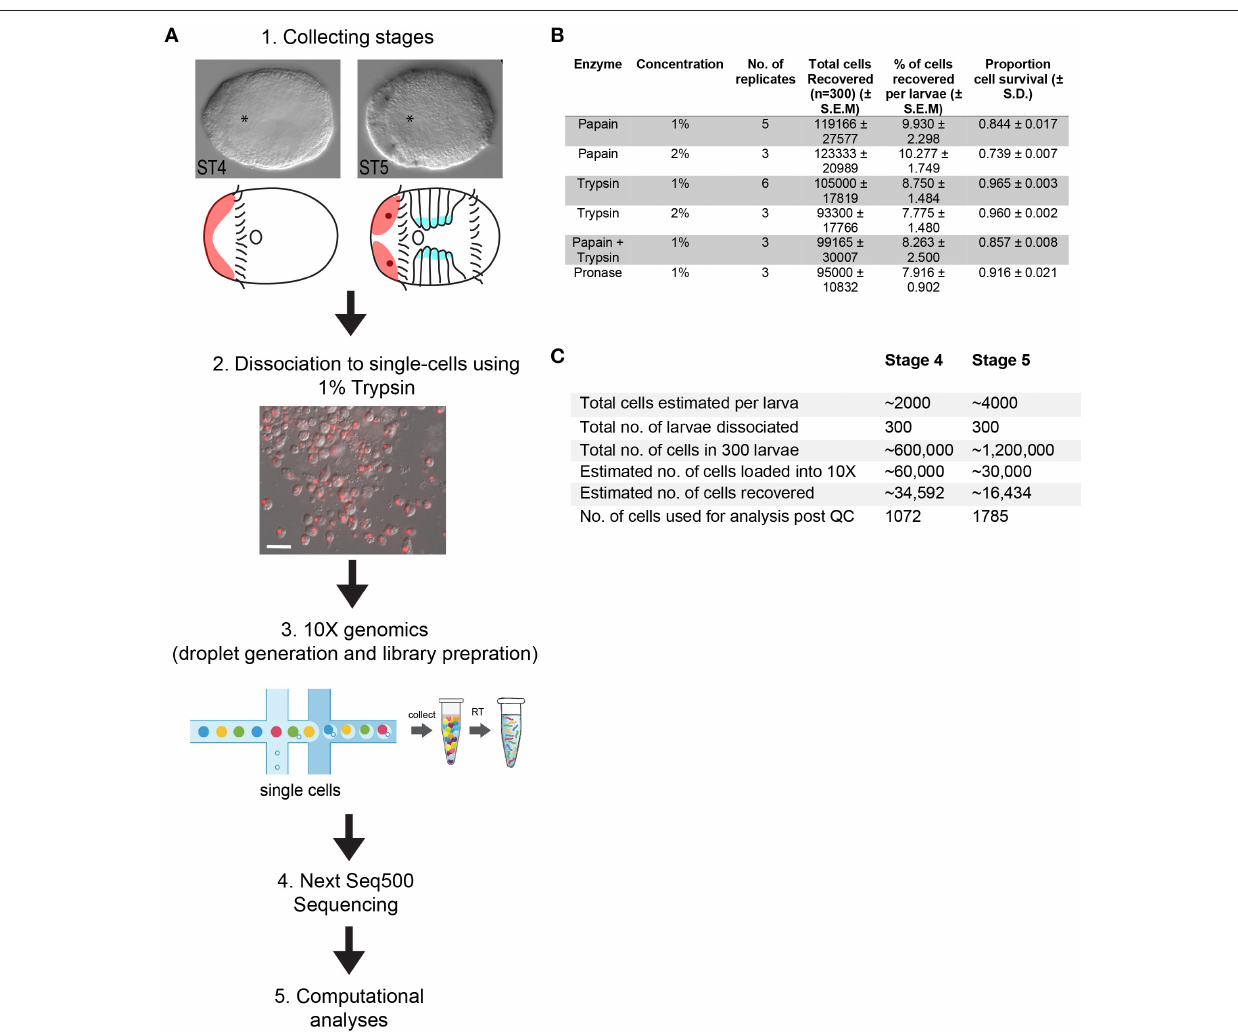
ppt) with 50 ug/mL penicillin and 60 ug/mL streptomycin (PenStrep) (SigmaAldrich) at 19 ◦ C for 1–2 days until they reached stage 4 prototroch or stage 5 ( Figure 1A ; 1). For single-cell dissociation, 300 larvae from a single brood (i.e., from one male and female) for each stage were then collected into 1.5 mL centrifuge tubes and equilibrated in Ca 2 + /Mg 2 + -free ASW (CMFSW). The recipe for the CMFSW used in this study is